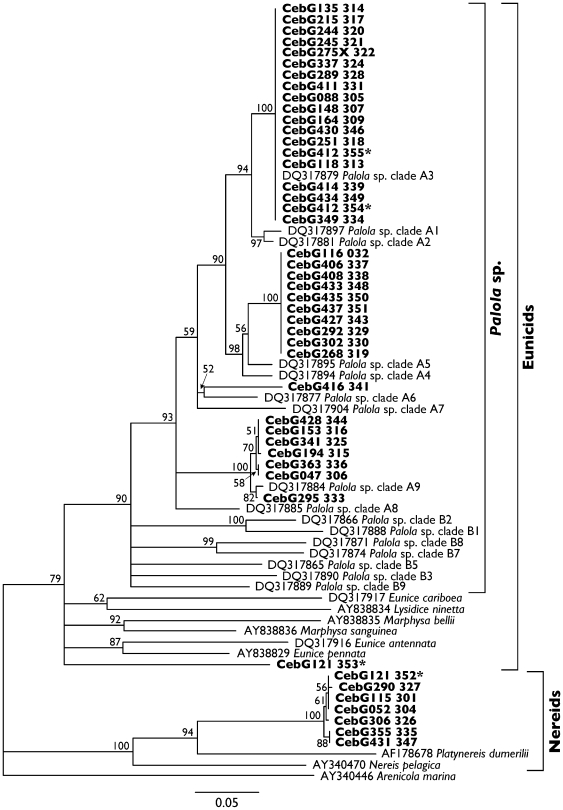
Neighbor-joining tree constructed from Kimura 2-parameter distances [48] of sequences of a region of the mitochondrial 16S gene.Bootstrap values from 1000 replicates are presented on branches; branches with bootstrap values less than 50% were collapsed. The tree is rooted to a sequence from Arenicola marina (Order Capitellida, Family Arenicolidae). Sequences obtained from feces are indicated in bold; names include the specimen code and fecal sample number. Names of sequences of polychaetes from GenBank are given with their GenBank accession numbers. Sequences from fecal materials of CebG121 and CebG412, the two individuals that defecated twice over a 24-hour period, are indicated with asterisks.